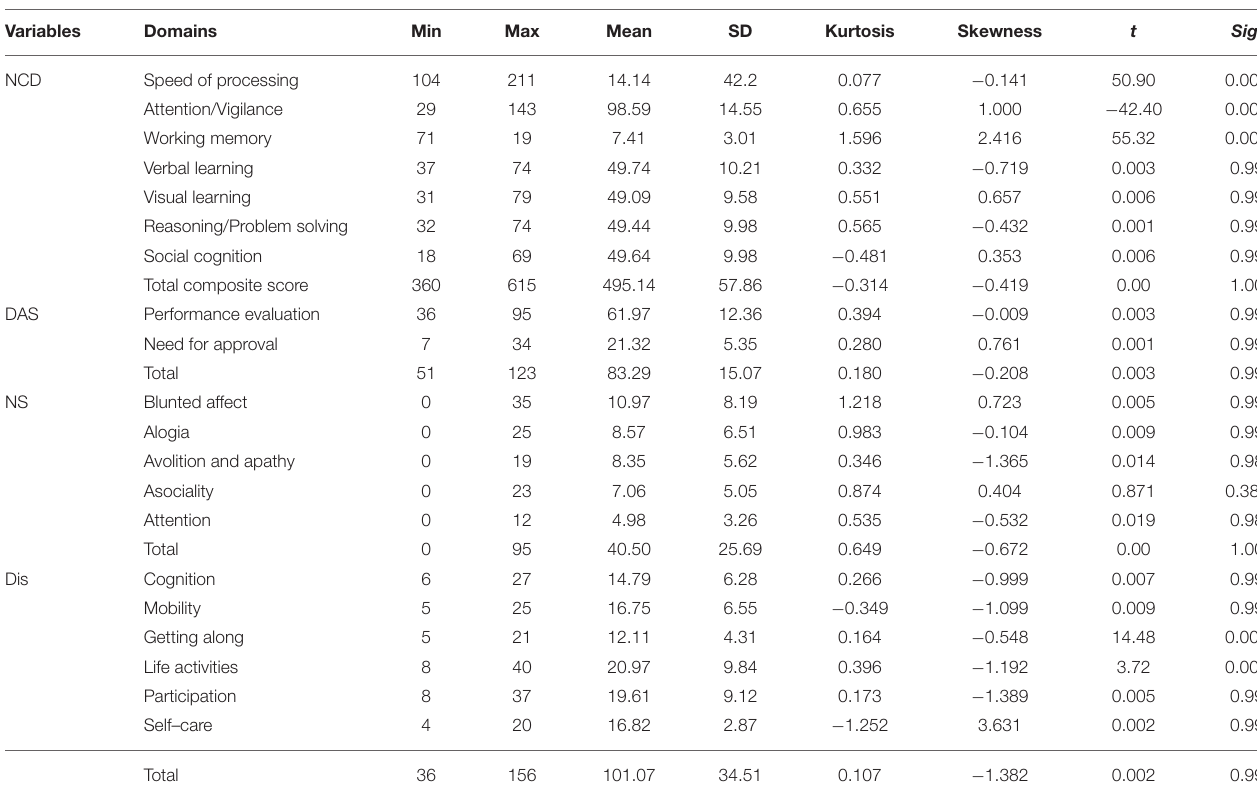
TABLE 2 | Descriptive statistic of Variables ( n =